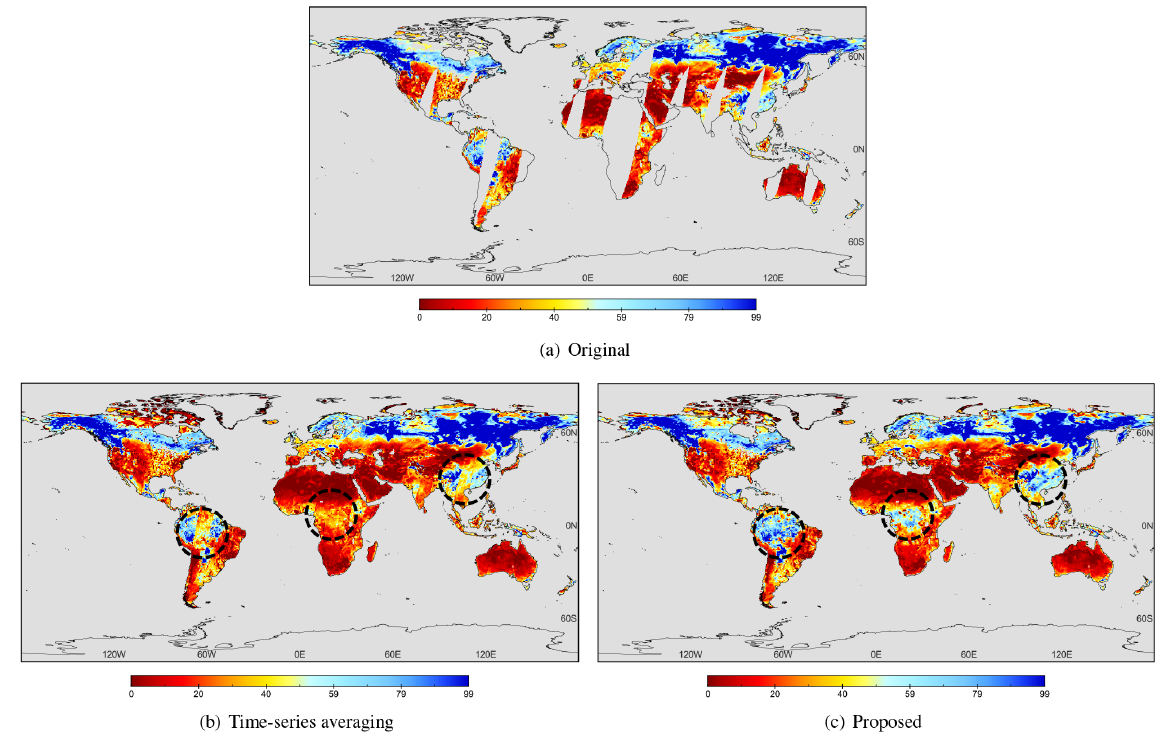
Figure 12. Original and time-series averaging and proposed global soil moisture results on 10 September 2016.